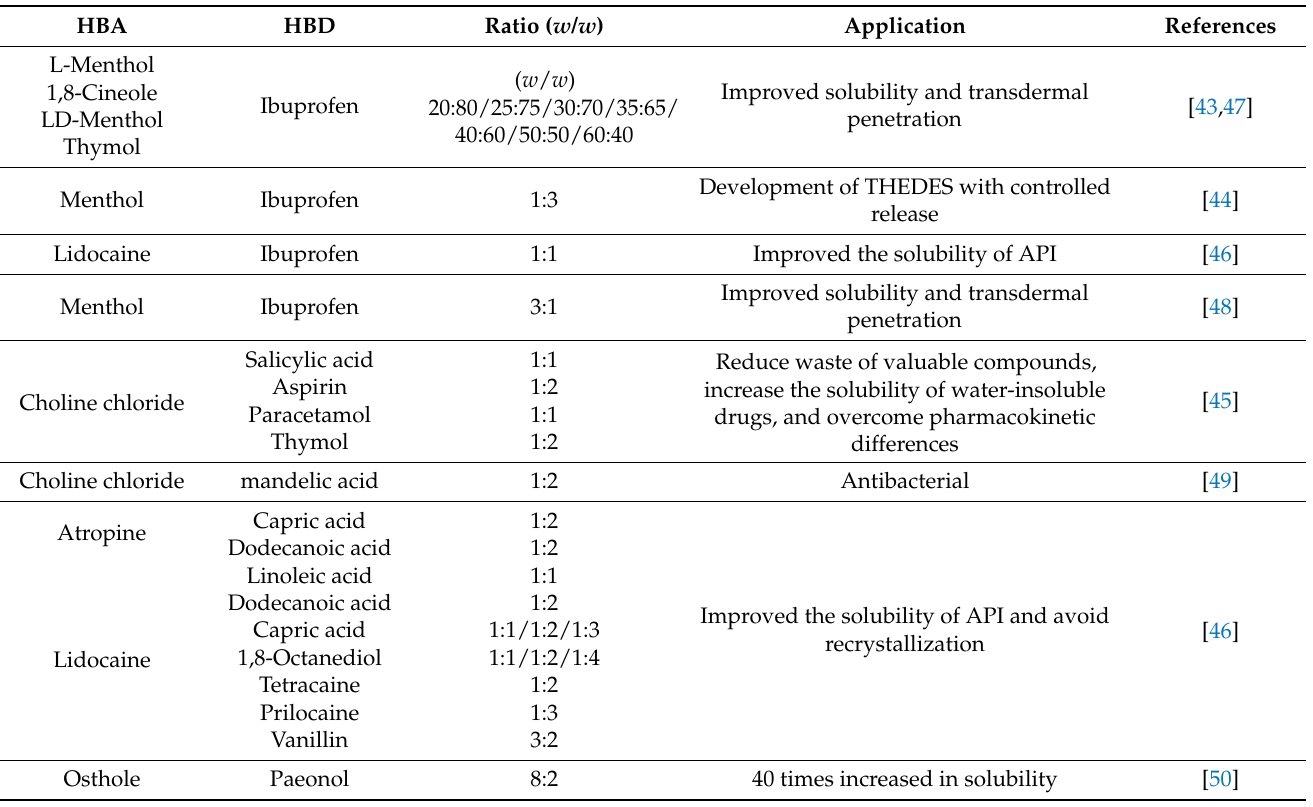
Table 2. The composition and application of